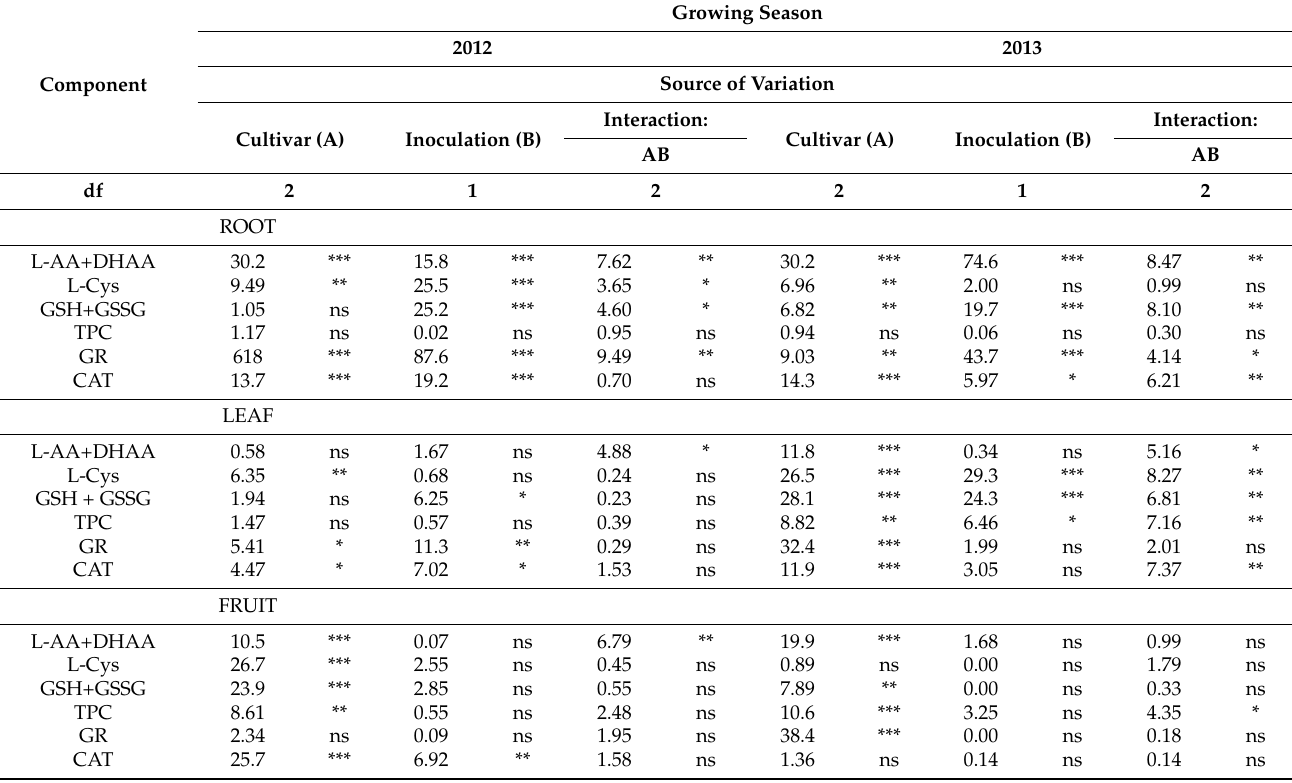
Table 1. Summary of analysis of variance (ANOVA) for the components tested. Values of F for particular sources of variation and their significance depending on the growing season, tissue type, and component